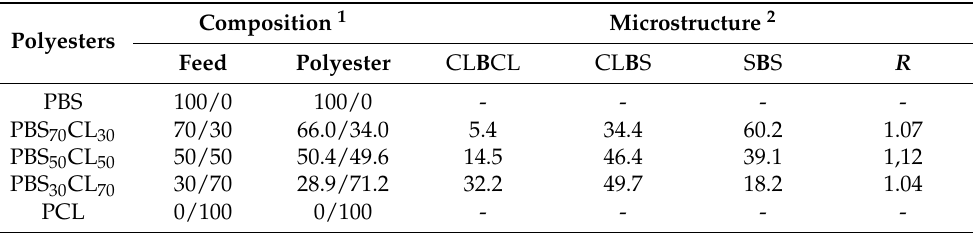
Table 3. Molar composition and microstructure of PBS and PCL polyesters and PBS x CL y copolyesters. Composition 1 Microstructure 2 Polyesters Feed Polyester CL B CL CL B S S B S R PBS 100/0 100/0 - - - - PBS 70 CL 30 70/30 66.0/34.0 PBS 30 CL 70 30/70 28.9/71.2 32.2 49.7 18.2 1.04 PCL 0/100 0/100 - - -